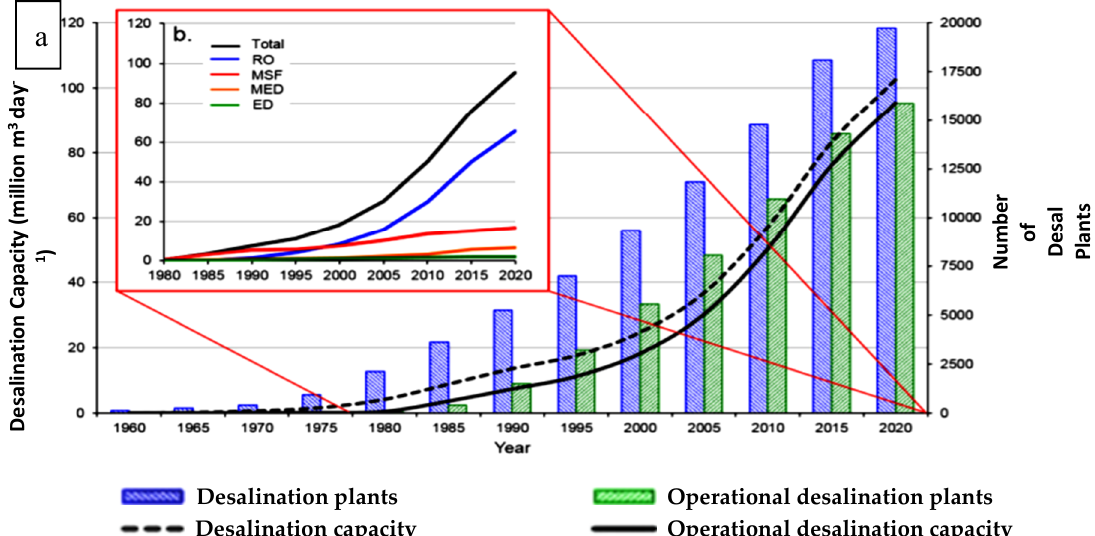
Figure 3. ( a ) Desalination plants worldwide and ( b ) share of different desalination processes [6].